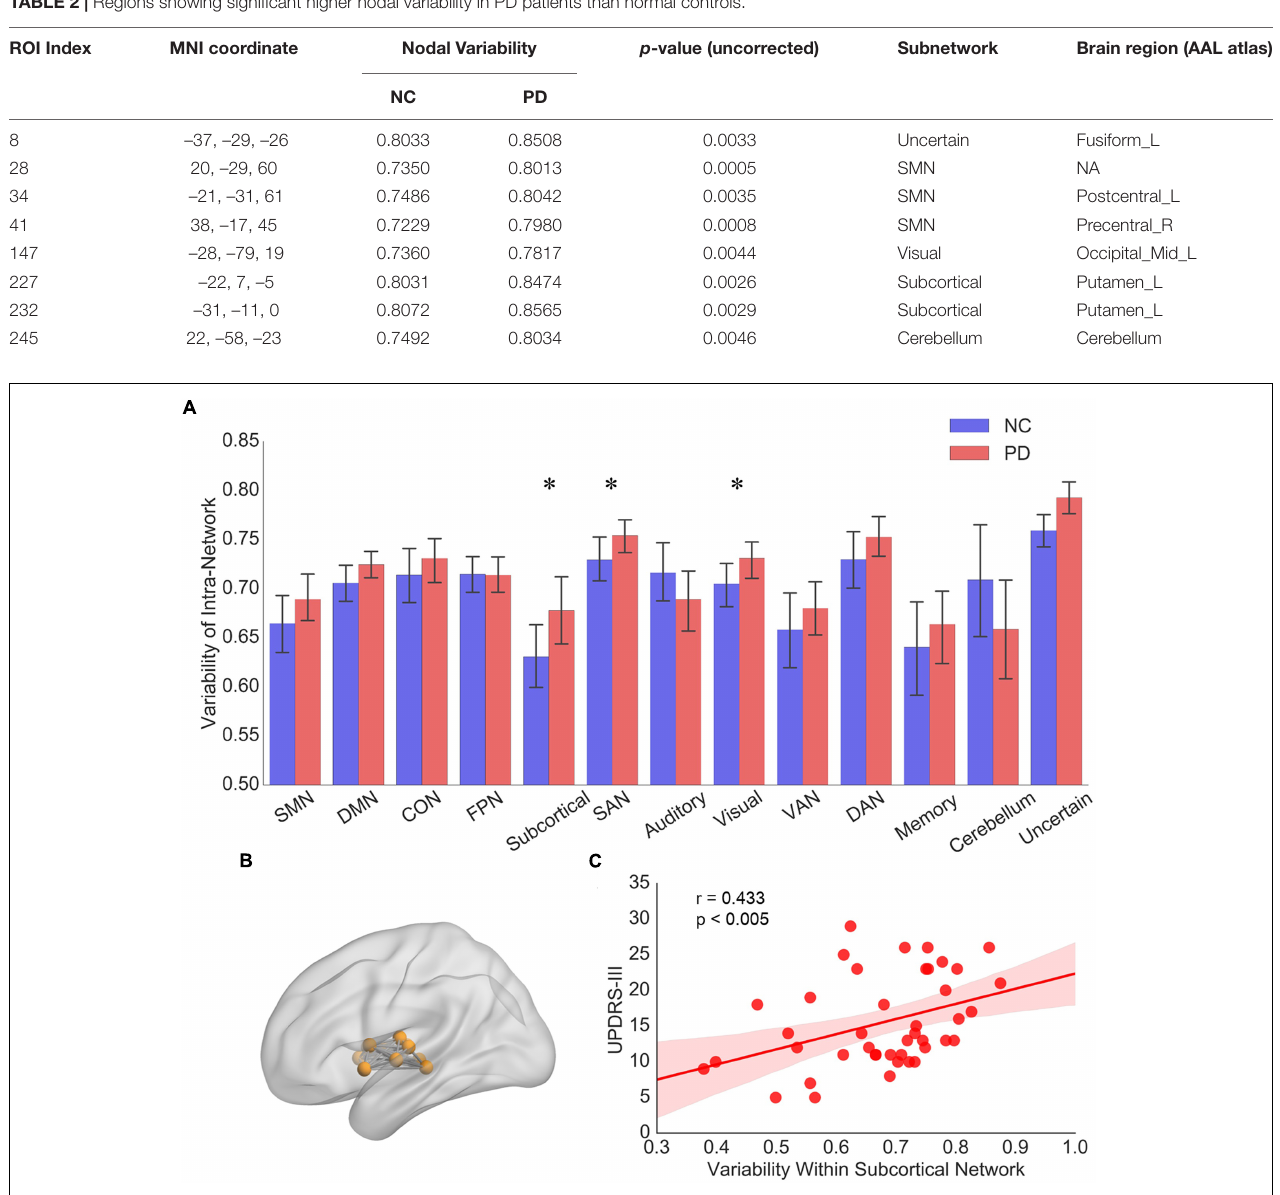
FIGURE 2 | (A) The intra-network variability of 13 subnetworks for PD patients and NCs, respectively. Error bars represent mean and standard errors of the two groups, respectively. ∗ p < 0.05. (B) Topographic representation of the nodes and connectivity within subcortical network. (C) Scatter plots of intra-network variability of subcortical network with respect to the UPDRS-III score in PD patients. Each dot indicates one subject. Linear regression line with 95% confidence interval for best-fit line (shading area), as well as r and p values (Spearman’s correlation coefficient) are provided.